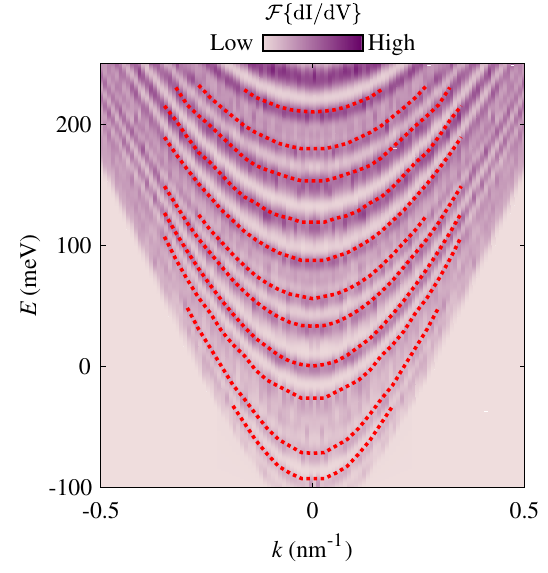
FIG. 10. Tight-binding calculation of InAs nanowires ’ band structure. Dotted lines mark some of the calculated